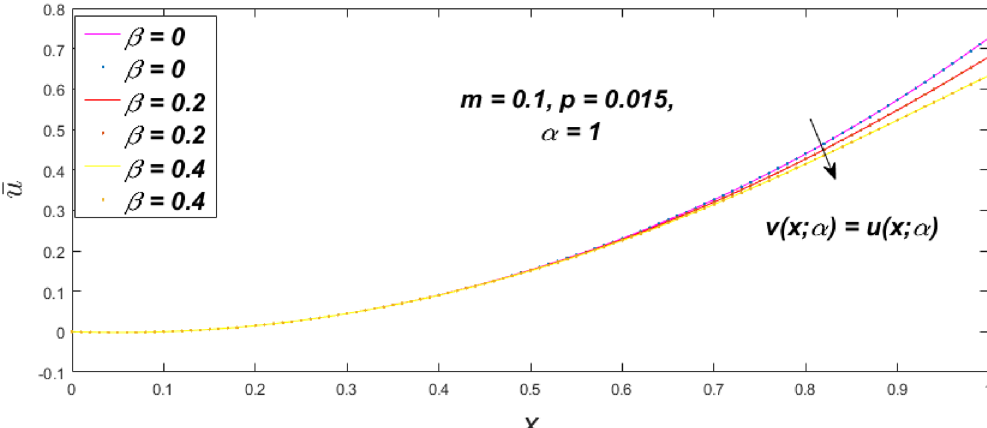
Figure 31. Fuzzy velocity for the impact of β .